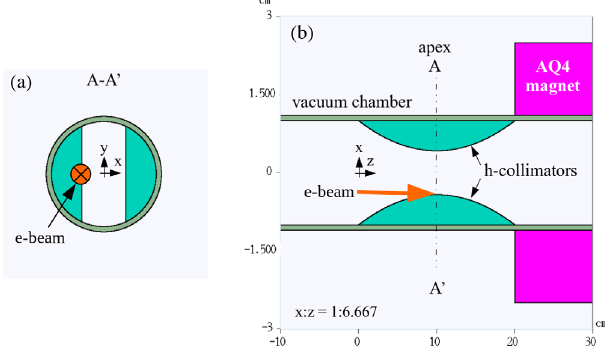
FIG. 2. Simplified horizontal collimator geometry implemented with MARS . Shown in (a) is a cross section through the collimator apex at z ¼ 10 cm with the e-beam into the page, and in (b) is an anamorphic view of a lateral slice at beam elevation ( y ¼ 0 ).